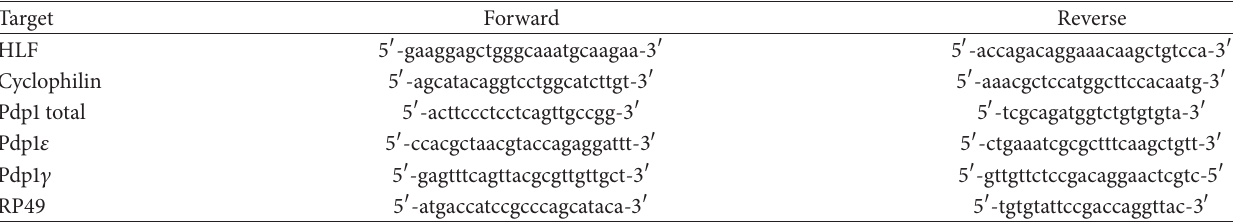
Table 1: Primers used for the mRNA